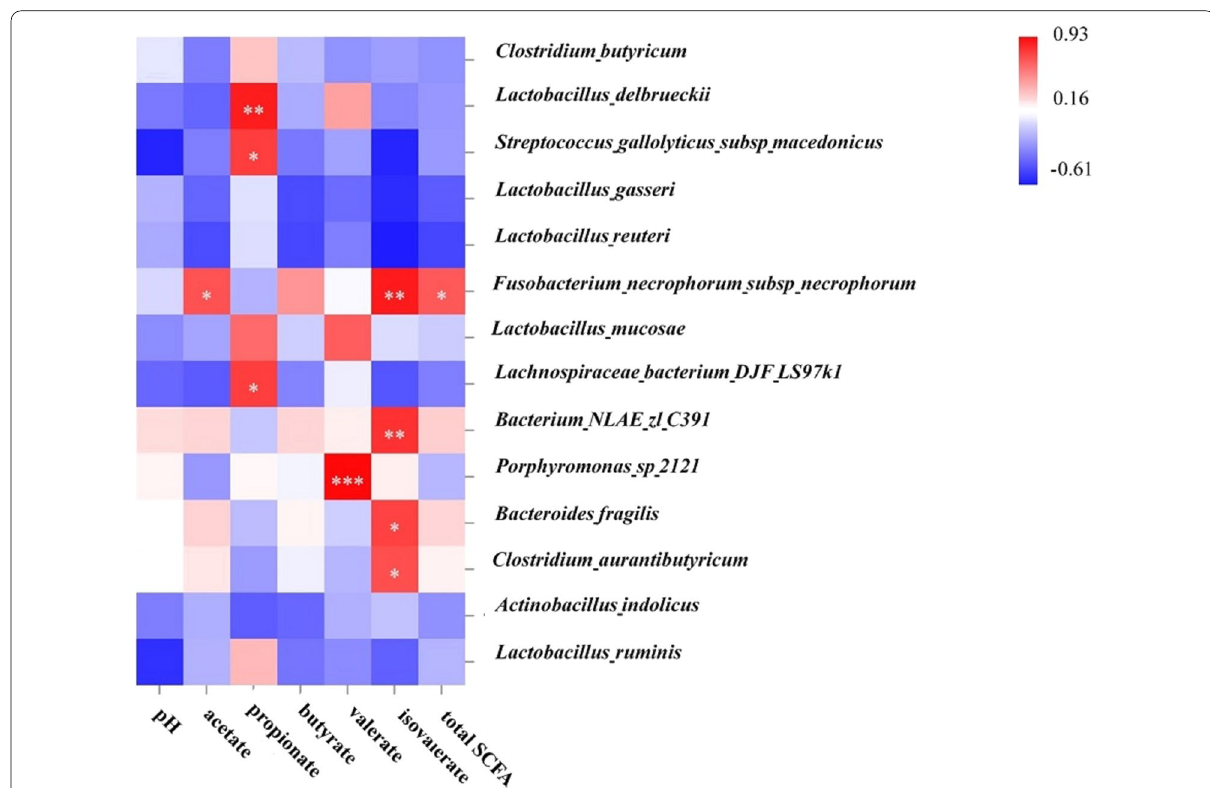
Fig. 5 Pearson correlation analysis between bacteria and the concentration of volatile fatty acids (VFA), pH in ileal digesta of finishing pigs. The cells are colored based on the Pearson’s correlation coefficient. Red represents positive correlation. Blue represents negative correlation, and white represents no significant correlation. An asterisk represents significant correlation ( P < 0.05), and double asterisk represents very significant correlation ( P <